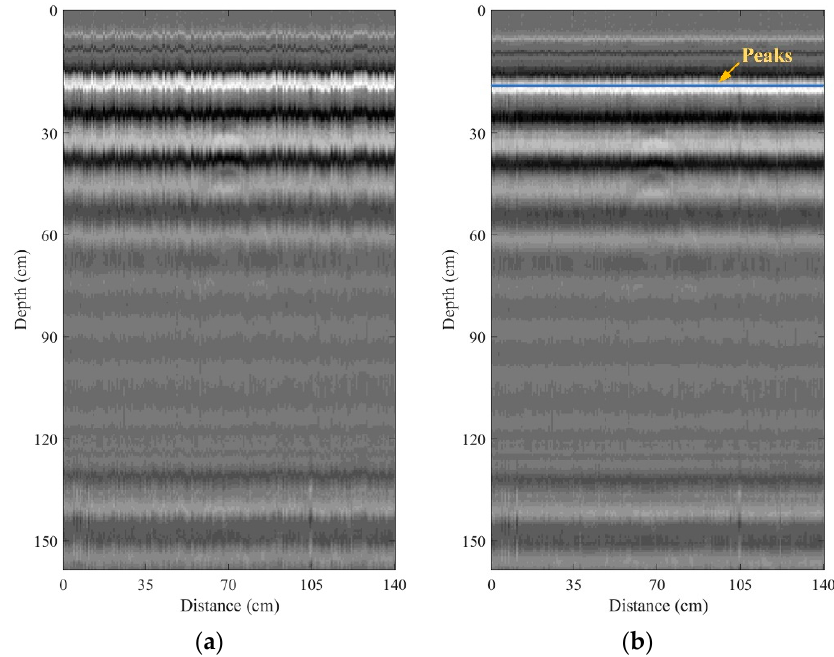
Figure 8. Examples of the B-scan image: ( a ) before; ( b ) after performing the time alignment.